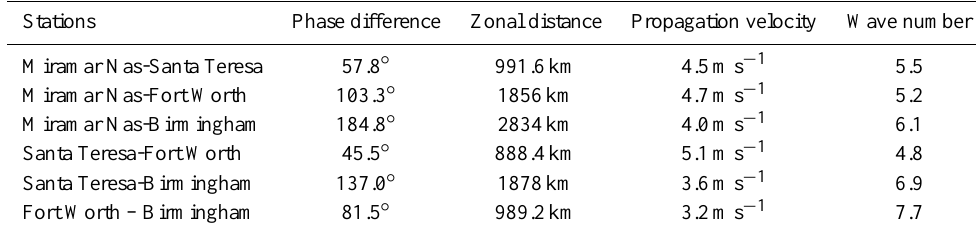
Table 1. Propagation parameters of quasi 16-day wave for meridional wind component in